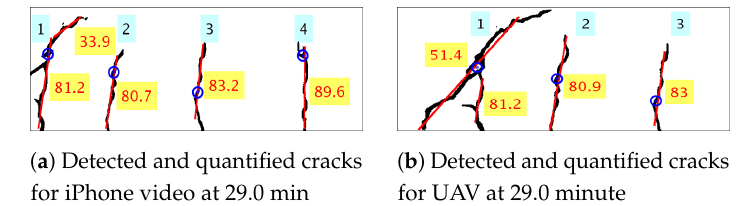
Figure 12. The red fitted line shows dominant crack orientation in degrees (red in yellow text box) of individual cracks which are numbered from left to right (black in cyan text box), for image frame at 29.0 min both for iPhone and UAV